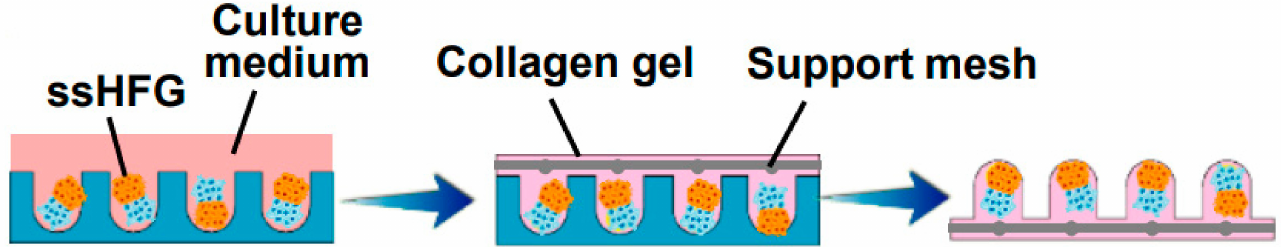
Figure 5. Self-sorted HF germs (ssHFGs) were grown in culture medium and later embedded in collagen gel to enable their transplantation. Reproduced with permission from